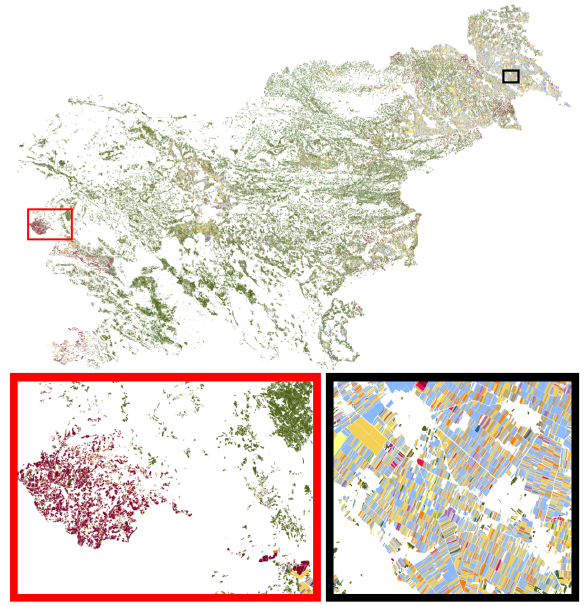
black has small fields with various crop types clustered very close together.